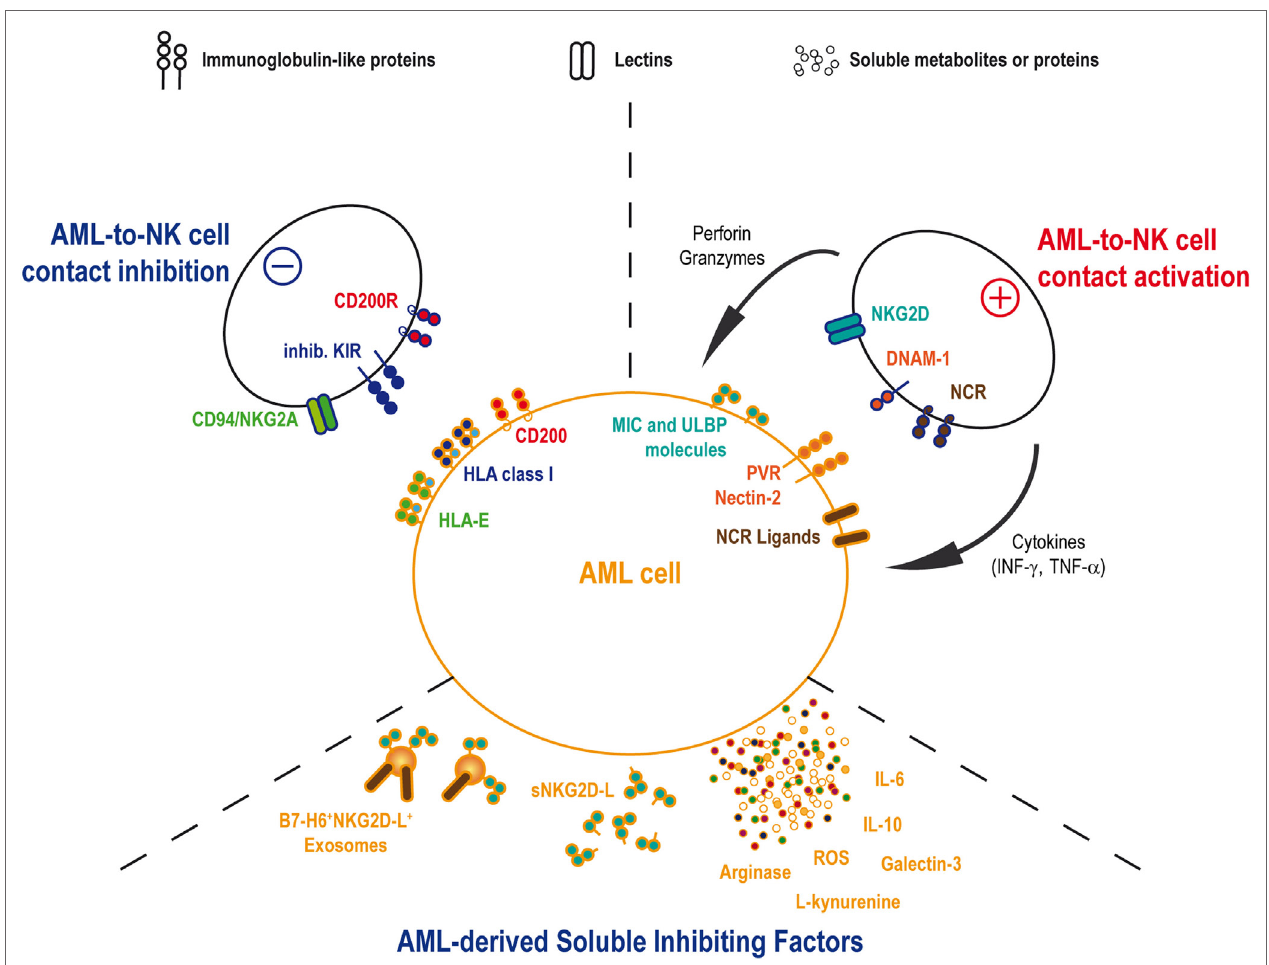
FiGURe 1 | AML and NK cells interactions . AML and NK cells will interact by cell-to-cell contact as well as soluble factors. NK cell functions, including cytotoxicity and cytokines release, will be activated through the binding of activating receptors onto the cognate ligands on AML blast. Conversely, AML cell will attempt to inhibit NK cell functions by mobilizing ligands for inhibitory NK receptors. In the same time, AML will secrete some inhibitory soluble agents in order to reduce NK cell efficacy to detect and eliminate